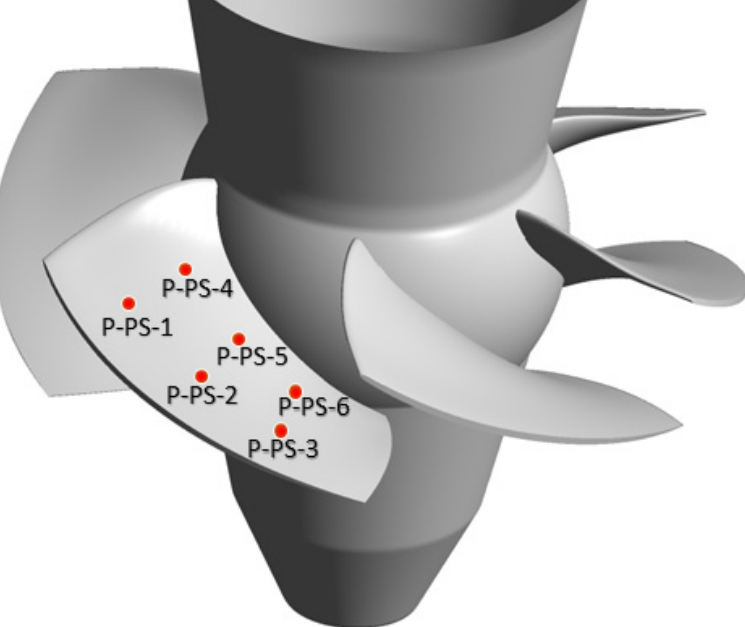
Figure 3. Runner and monitor points on the blade pressure side.